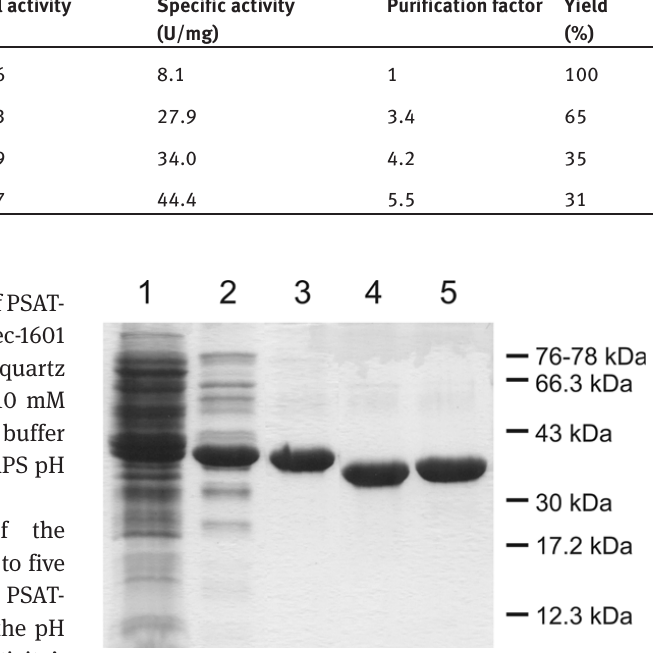
Figure 1: 12.5% SDS-PAGE. PSAT-BALC on lane 1 (crude extract; 20 µg/lane), 2 (the same after DEAE Sepharose CL-6B; 8 µg/lane), and 3 (the same after Mono Q HR 5/5; 5 µg/lane); Final purified PSAT- BCIRA lane 4 (5µg/lane), and PSAT-ECOLI lane 5 (5µg/lane). See also Tables 1 and 2. Position of the molecular weight markers 12.3-78 kDa (LKB-Pharmacia) are shown on the right.